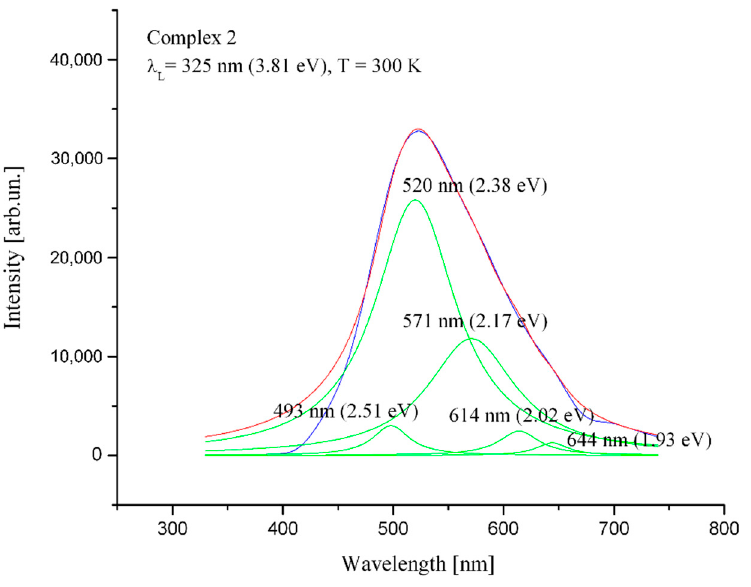
Figure 7. Photoluminescence characteristics of Complex 2 . Blue, curve of the experimental intensity; red, curve of the fitted total intensity; green, curve of the fitted individual